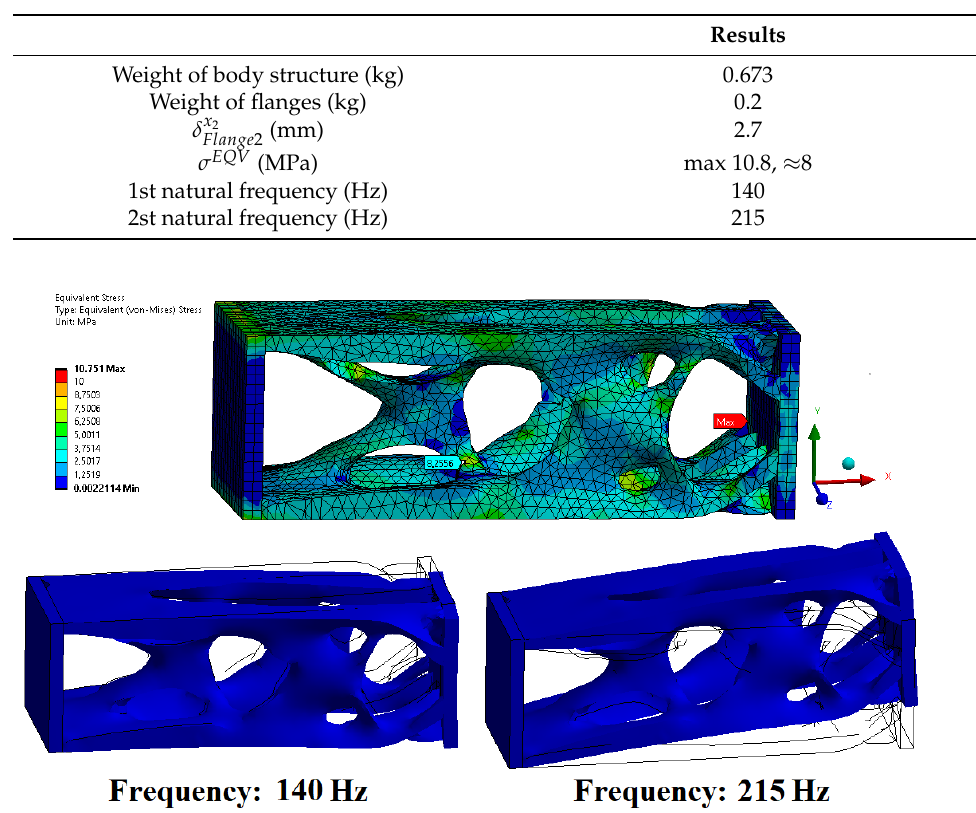
Figure 14. The resulting geometry after topological optimization, mesh and displacement. Table 8. The basic results of Model 1.